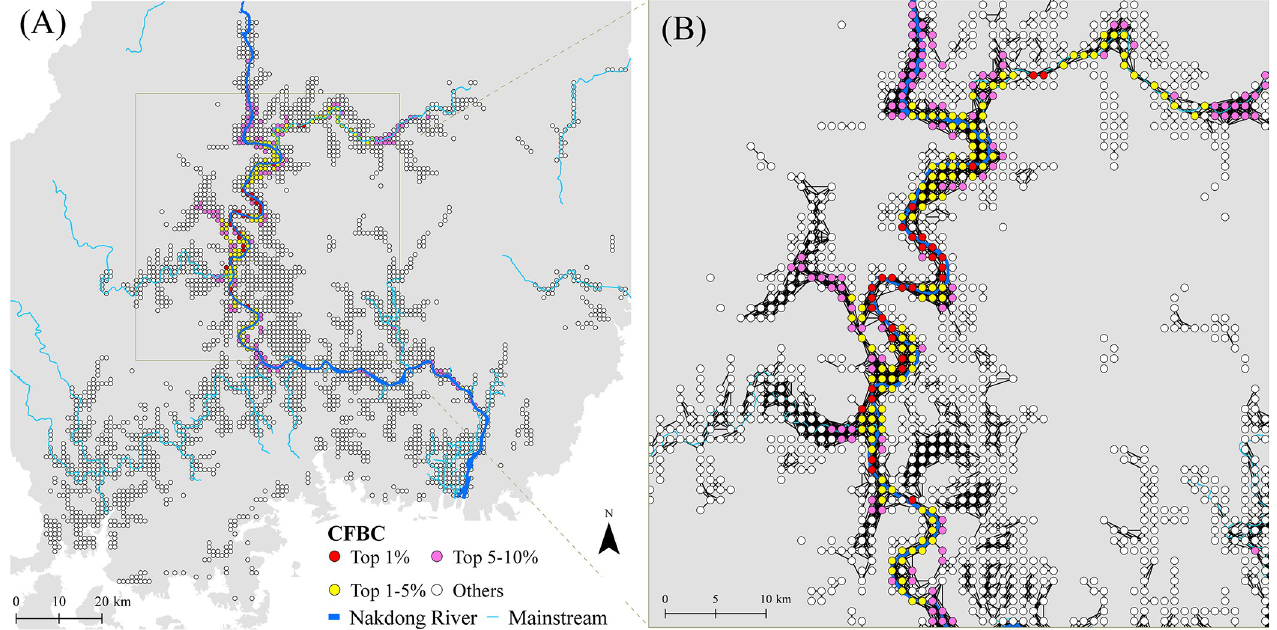
Fig 11. Connectivity level (current flow betweenness centrality, CFBC) of habitat nodes for genetic connectivity of nutria populations (base map data source: https://gadm.org/). (A) CFBC of habitat nodes measured at a cost distance threshold of 5,000 within the middle and downstream regions of the Nakdong River Basin. Circles represent habitat nodes. Red and yellow circles indicate priority habitat nodes of high connectivity for invasive species management. (B) Enlarged view of a key control area including high-priority habitat nodes along the Nakdong River and its major adjacent tributaries. Links connecting habitat nodes are also shown. River and stream data were derived from the OpenStreetMap database (http://www.openstreetmap.org).